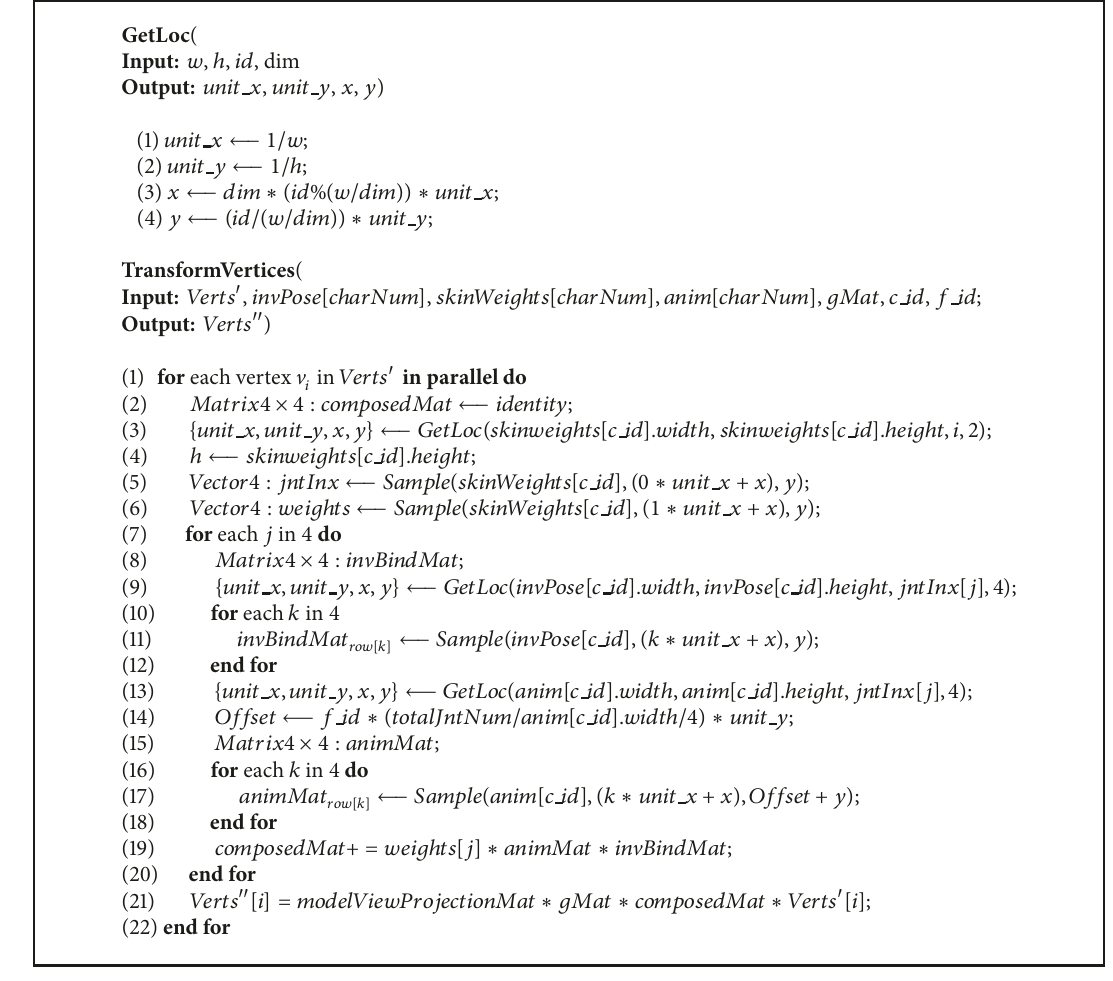
Algorithm 2: Transforming vertices of an instance in vertex shader.